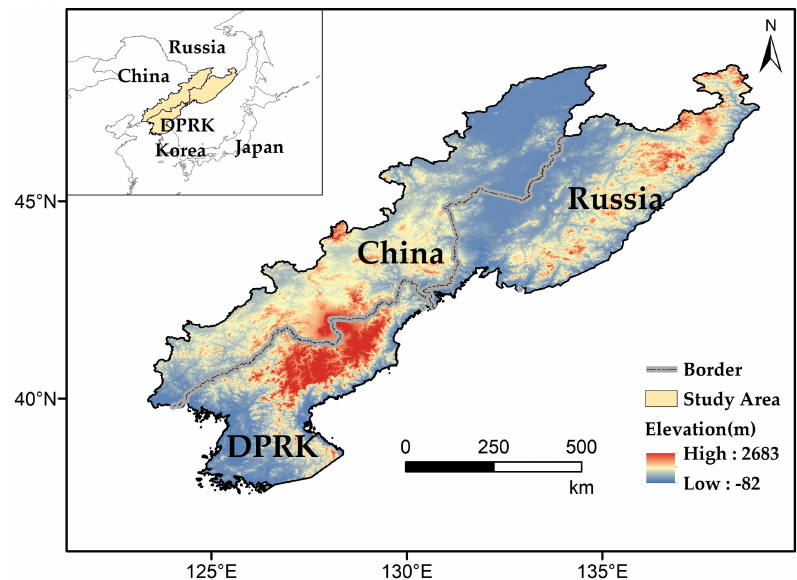
Figure 1. Geographical location and elevation of China–DPRK–Russia cross-border